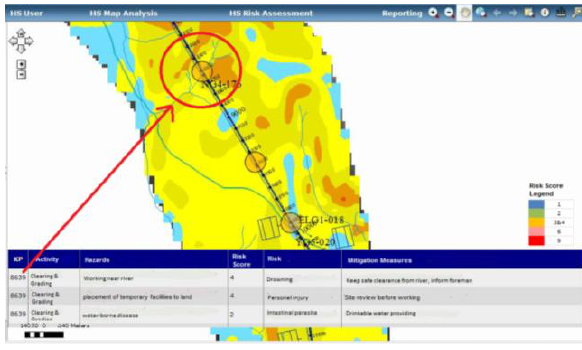
Figure9. User Interface Viewing the Hazards & Risk